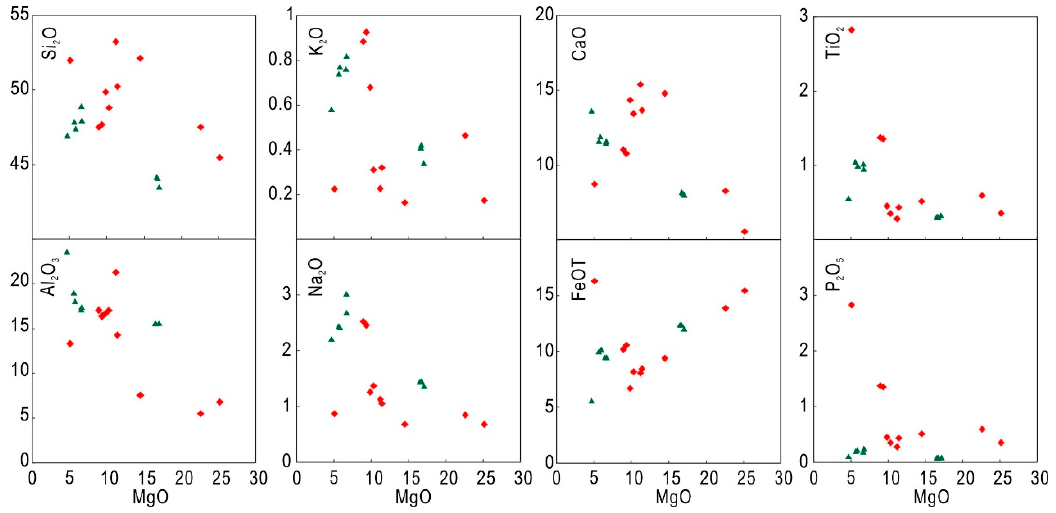
Figure 5. ( a ) TAS classification diagram and ( b ) Th–Co classification diagram (after [33]) for the Haoyaoerhudong gabbro.